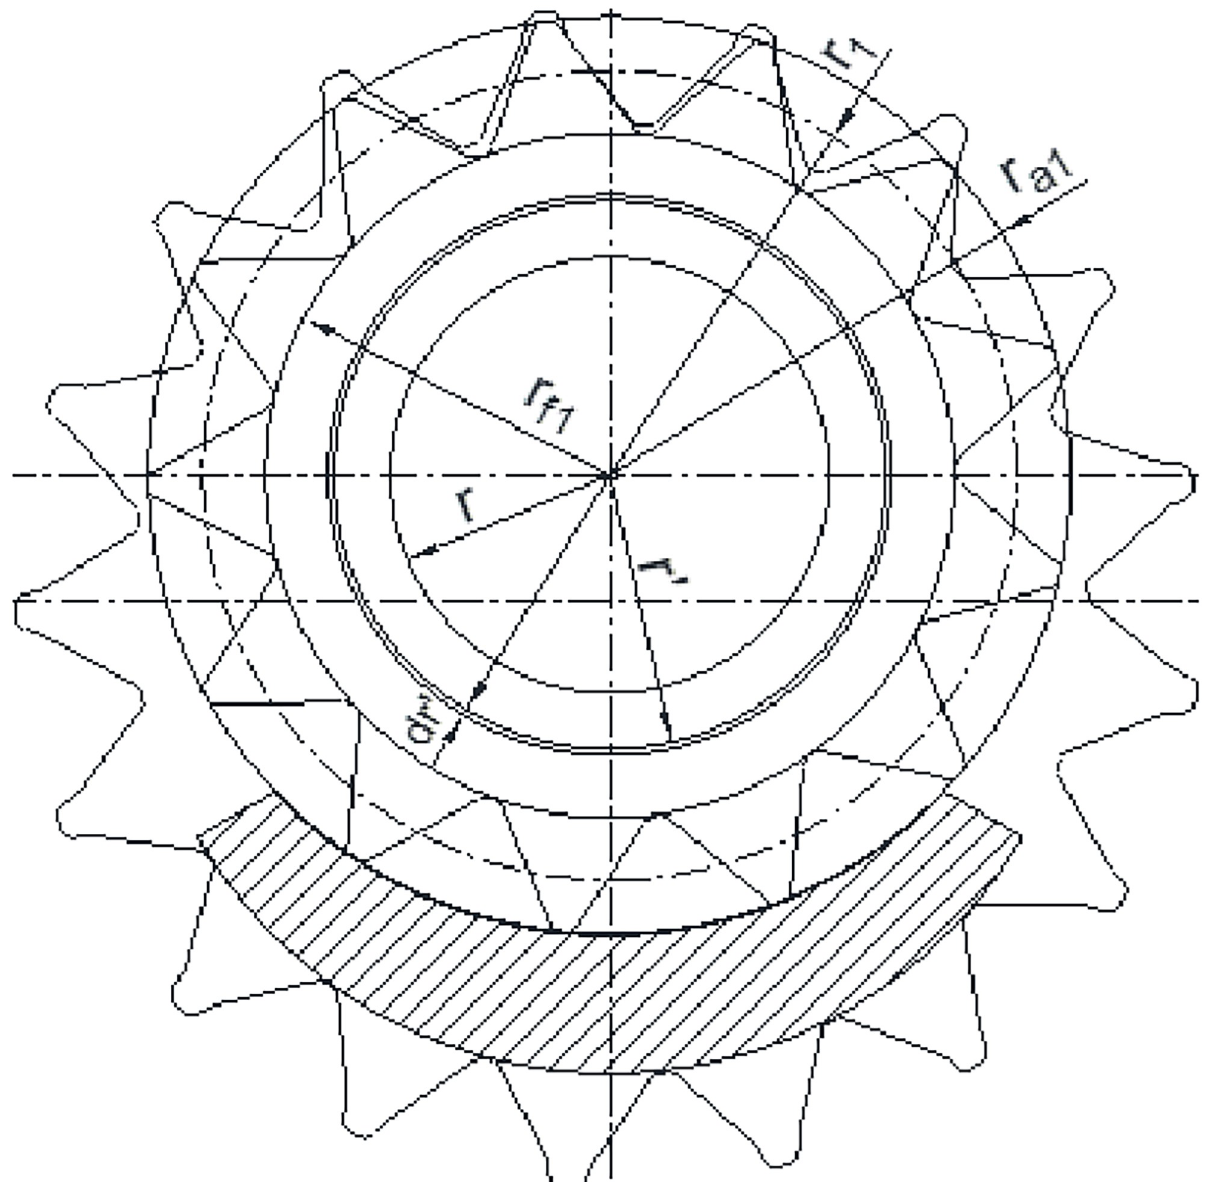
Fig 7. Simplified model of viscous friction on the end face of external